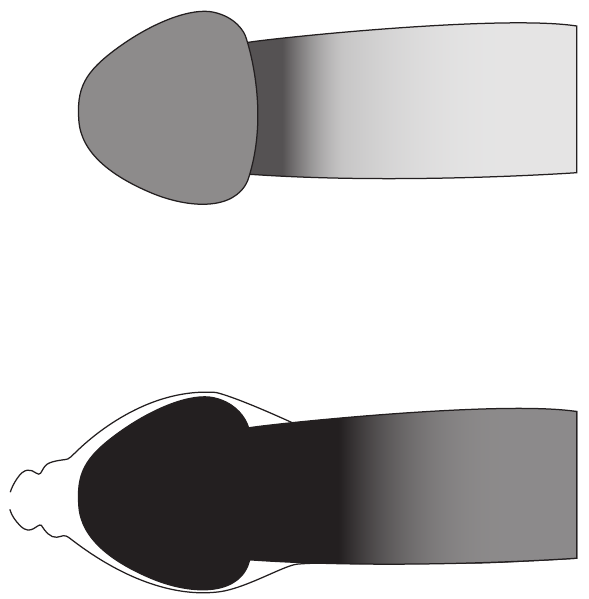
Figure 3: The circumcised and uncircumcised penis, depicting the di ff erences in prevalence of HPV between